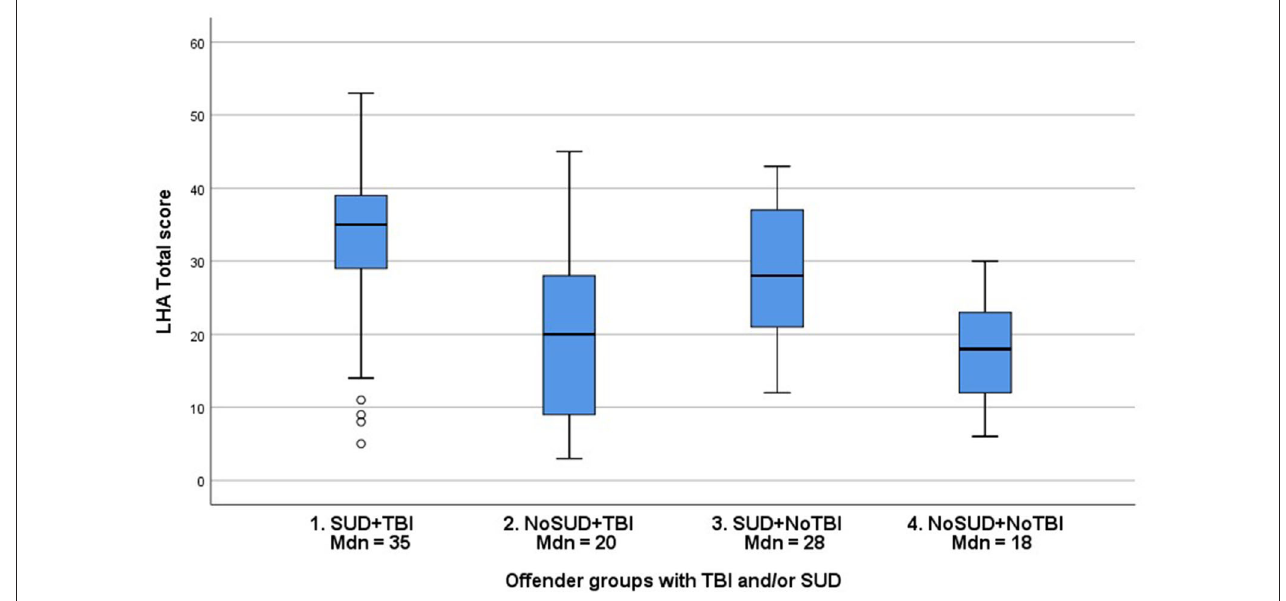
FIGURE 2 | Distribution (Median, Interquartile range) of LHA Total scores in groups of young violent offenders with or without TBI and/or SUD.